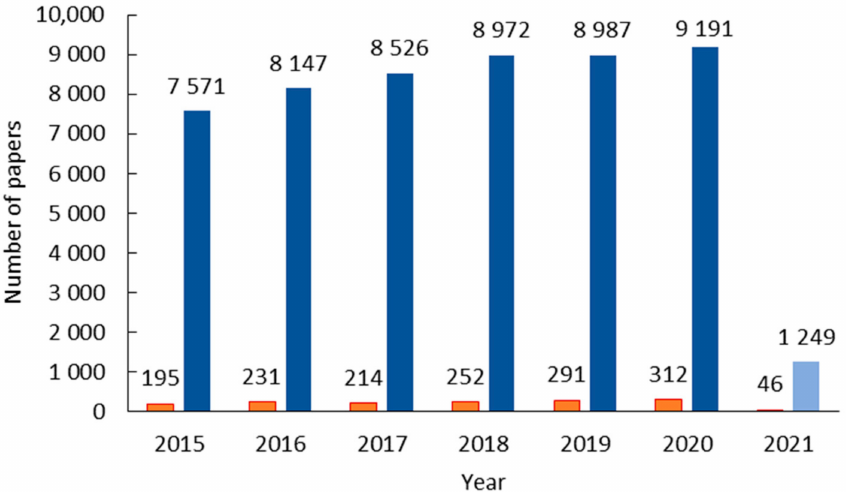
Figure 1. Number of scientific papers published from 2015 to 15th March 2021 concerning “ionic liquids” (blue columns) and “toxicity ionic liquids” (orange